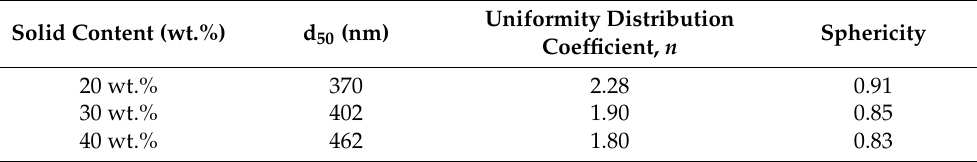
Figure 6. The PSD of ZnO particles ground for 30 min in CH 3 COOH solutions at a low concentration of 0.010 mol/L with different solid contents. ( a ) the interval mass distribution of ZnO particles; ( b ) the cumulative mass distribution of ZnO particles. Table 5. d 50 , n and sphericity values of ZnO particles ground for 30 min in CH 3 COOH solutions at a low concentration of 0.010 mol/L with di ff erent solid contents.